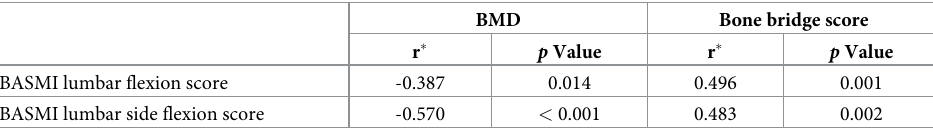
Table 4. Correlation of bone bridge and BMD with spinal mobility.